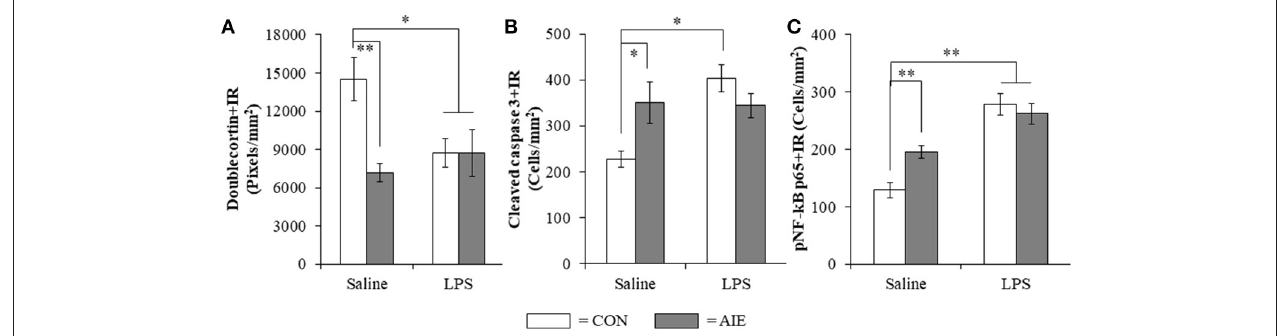
FIGURE 8 | Lipopolysaccharide (LPS) treatment mimicked the AIE-induced loss of doublecortin, and increased expression of cleaved caspase 3 and phosphorylation of the proinflammatory transcription factor nuclear factor kappa-light-chain-enhancer of activated B cells p65 (phosphorylated [pNF- κ B p65]) in the adult hippocampal dentate gyrus. (A) Quantification of doublecortin pixel density in the hippocampal dentate gyrus of adult rats (P80) revealed a significant reduction in AIE- (49% [ ± 5%]), CON + LPS- (41% [ ± 8%]), and AIE + LPS-treated animals (41% [ ± 12%]), relative to CONs. (B) Modified unbiased stereological quantification of cleaved caspase 3 + IR cells in the hippocampal dentate gyrus of adult rats revealed a significant increase in AIE- (54% [ ± 20%]), CON + LPS-treated animals (77% [ ± 13%]), and a tread toward an increase in AIE + LPS-treated animals (51% [ ± 11%]), relative to CONs. (C) Modified unbiased stereological quantification of pNF- κ B p65 + IR cells in the hippocampal dentate gyrus of adult rats revealed a significant increase in AIE- (52% [ ± 14%]), CON + LPS- (116% [ ± 9%]), and AIE + LPS-treated animals (104% [ ± 14%]), relative to CONs. Data are presented as mean ± SEM. * p < 0.05, ** p <